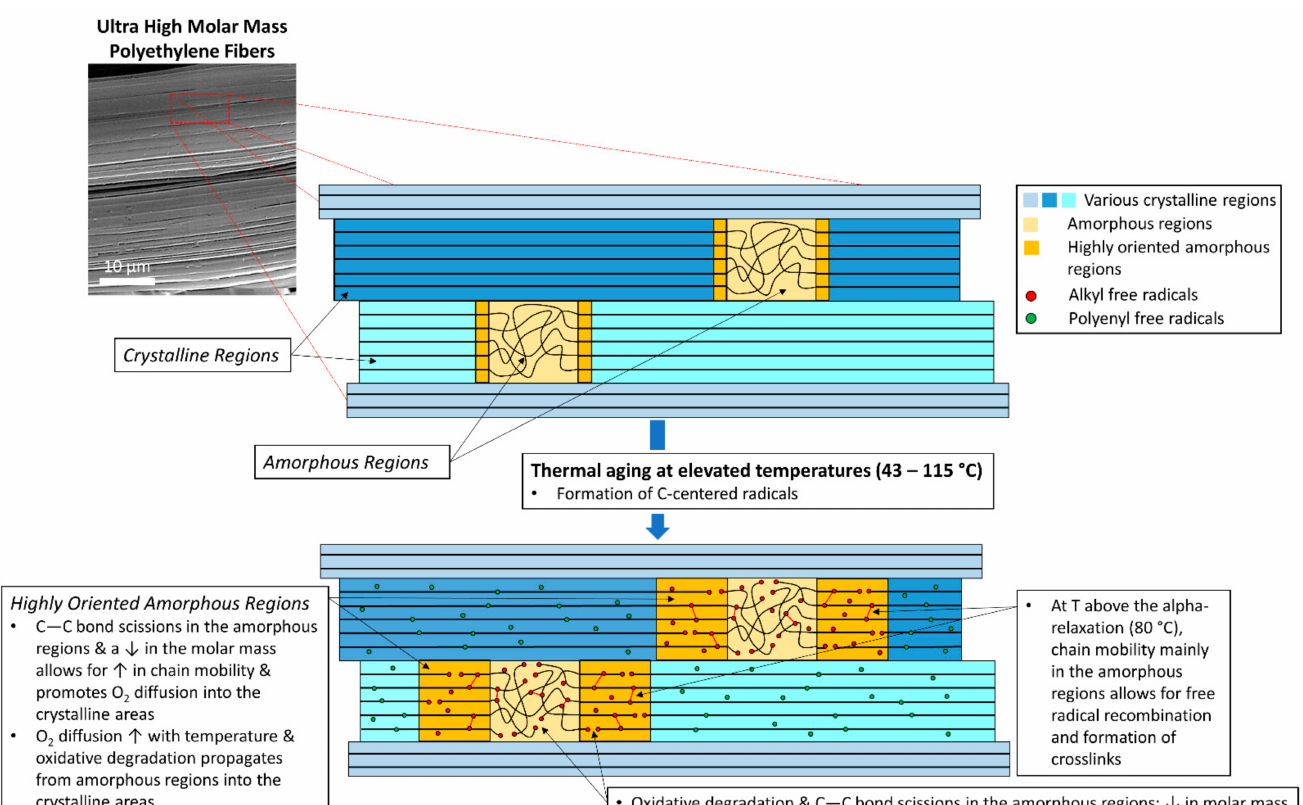
Figure 3. Thermal aging effects on ultra-high molar mass polyethylene fibers; C–C bond scissions, decrease in molar mass, and